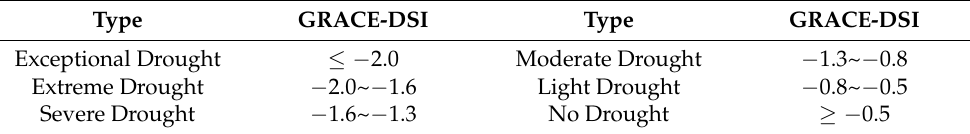
Table 1. GRACE-DSI drought grades